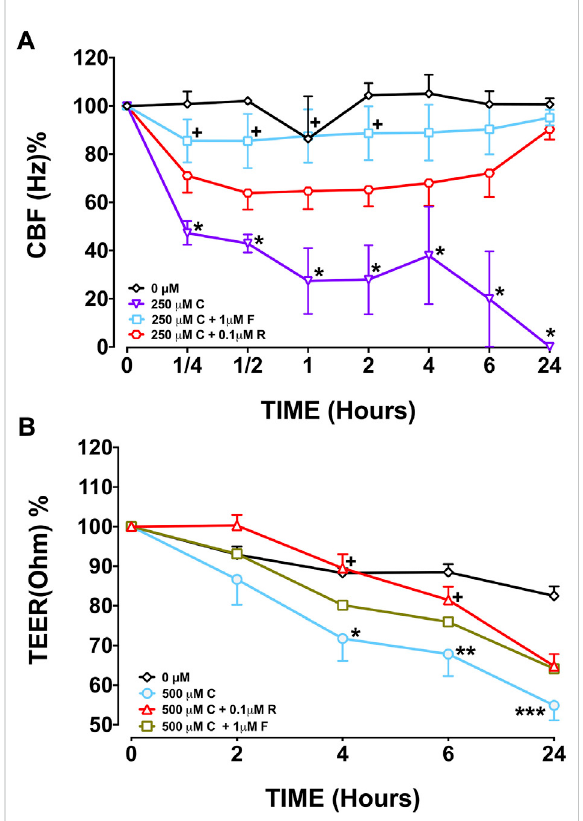
FIGURE 3 Effect of formoterol (F) and ro fl umilast (R) on CBF (A) and TEER (B) in bronchial epithelial cell (BEC) cultures of smokers incubated with 250 μ M capsaicin (C) Mean±SEM is displayed for smokers ( N = 13). (Figure 3A: * p < 0.0001 vs. 0 μ M capsaicin; + p < 0.05 vs. 250 μ M capsaicin; Figure 3B: * p < 0.05, ** p <